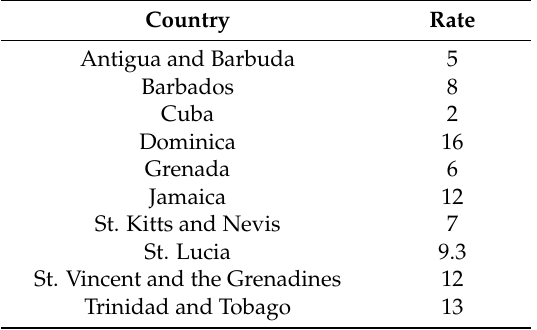
Table 1. List of Caribbean Countries by Neonatal Mortality Rate per 1000 live births. Country